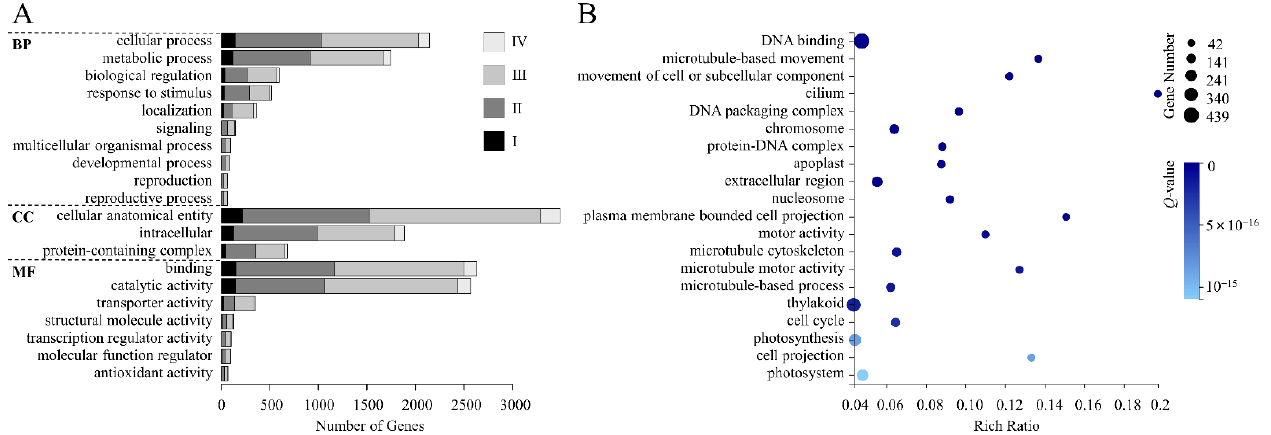
Figure 3. GO classification and enrichment. ( A , B ) GO functional classification ( A ) and enrichment ( B ) of DEGs. GO enrichment diagram shows the top 20 terms with low Q -values, the circle sizes indicate the DEG numbers, and the deeper colors indicate the lower Q -values.